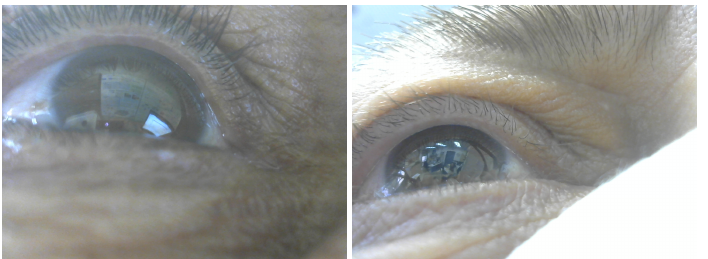
Figure 3. Left: RGB image with contact lenses, right: RGB image (without contact lenses) with light